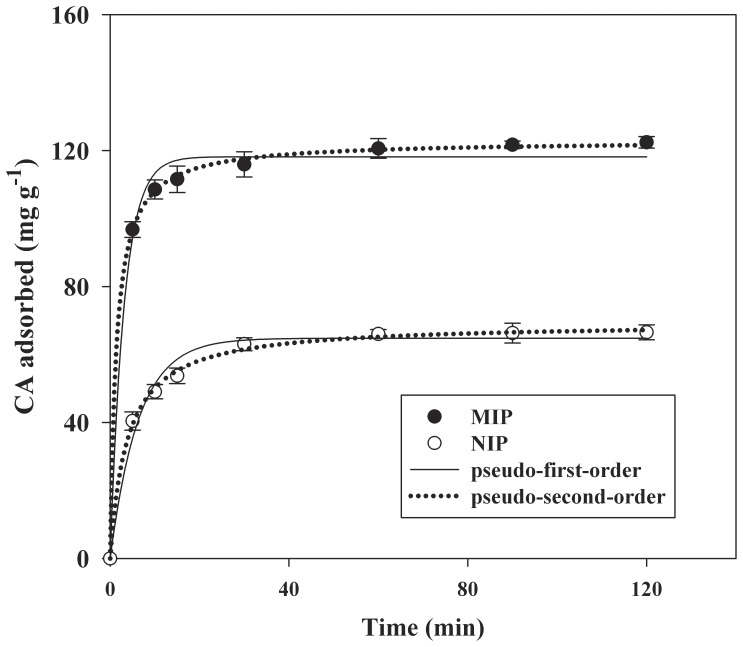
Adsorption kinetics of MIP and NIP for CA (mean ±SD, n = 3).